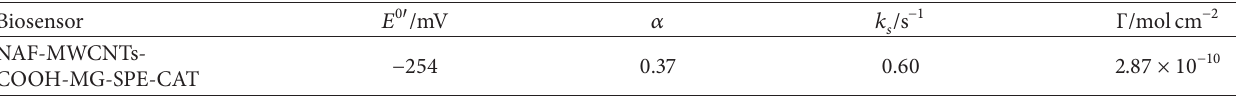
Table 5: Electrochemical parameters for immobilized catalase in the presence of nanomaterials on mesoporous graphite SPE. Biosensor